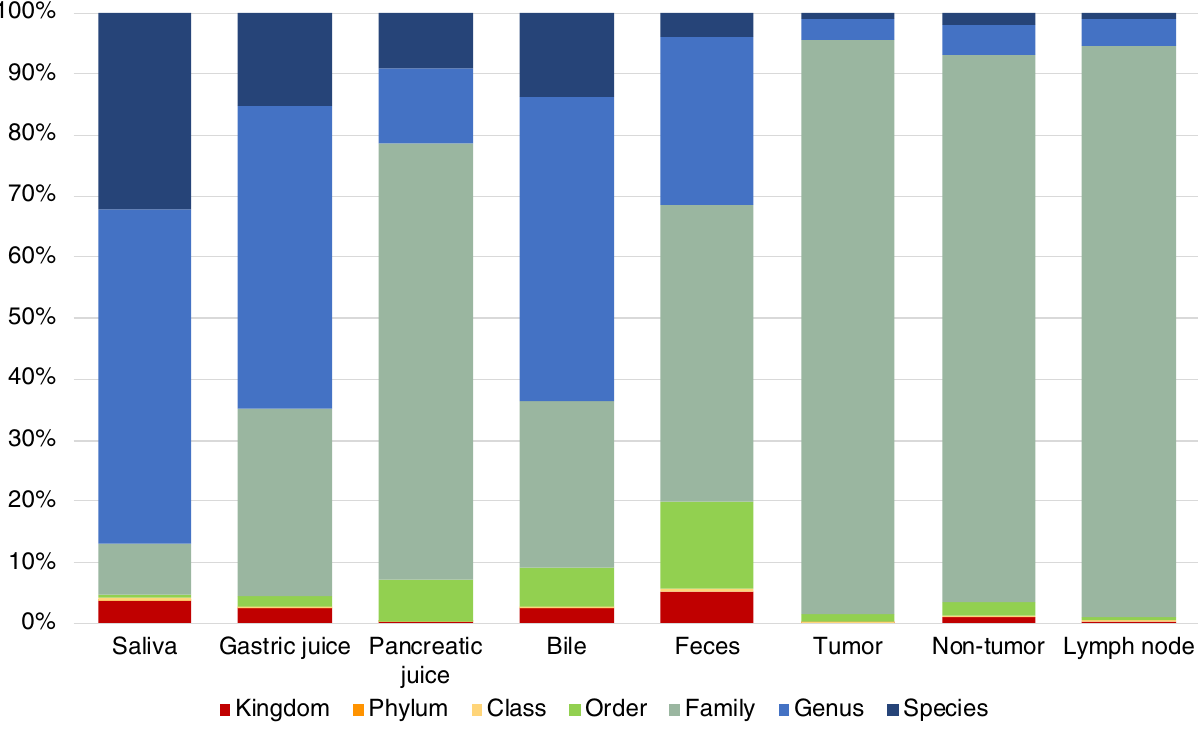
Figure 1. Coverage of taxonomy at each body fluid and tissue. The average relative abundance of taxonomy for patients at each site was used as coverage against the total